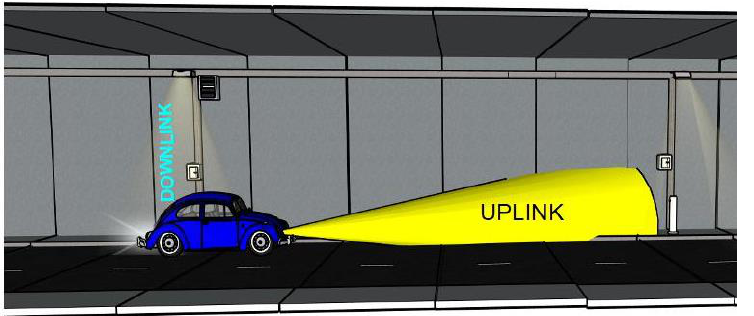
Figure 4. Graphical representation of the vehicular VLC communication system in V2I